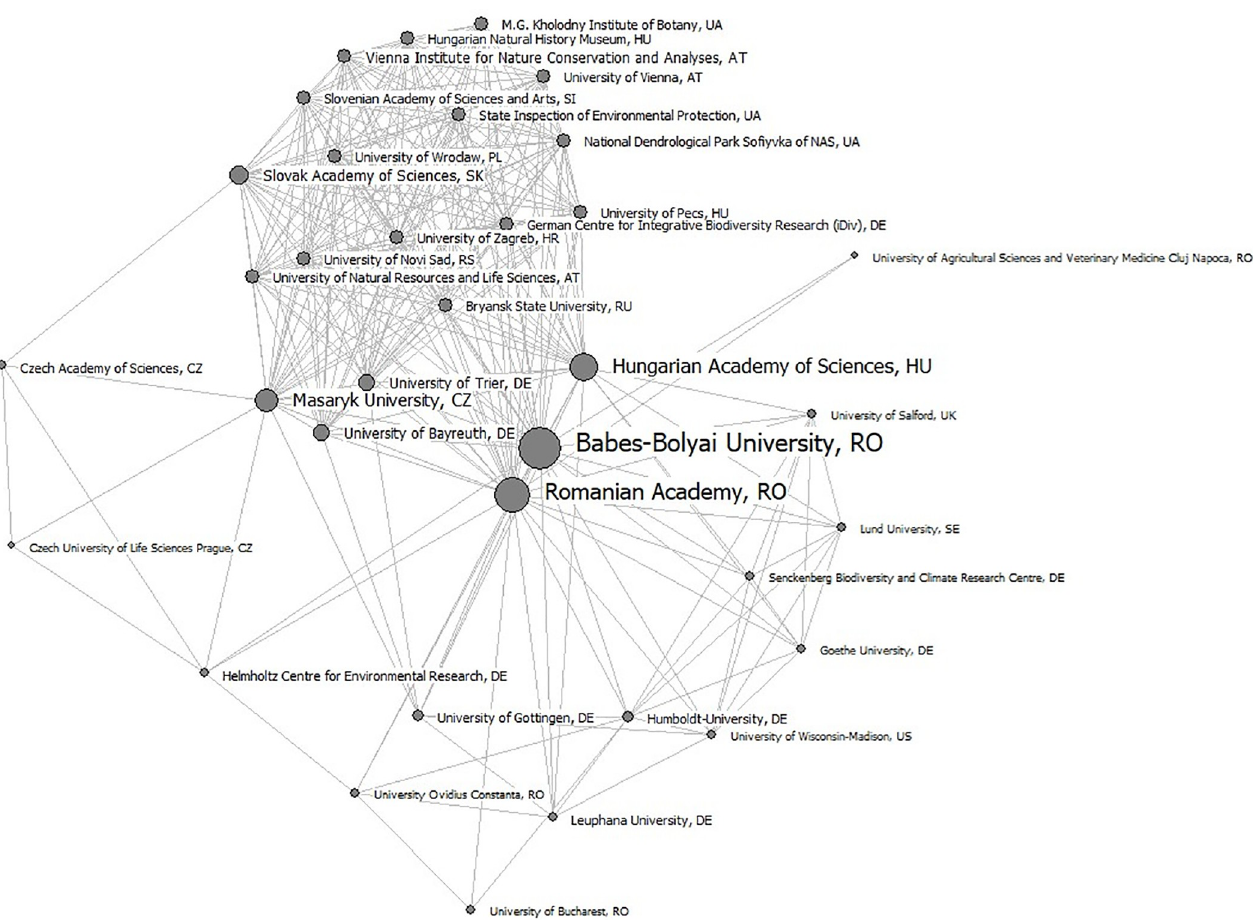
Fig 5. Network of the affiliations of authors publishing work about Romania’s grasslands. Size of nodes and labels are given by degree. Only affiliations with a degree centrality > 10 are shown.